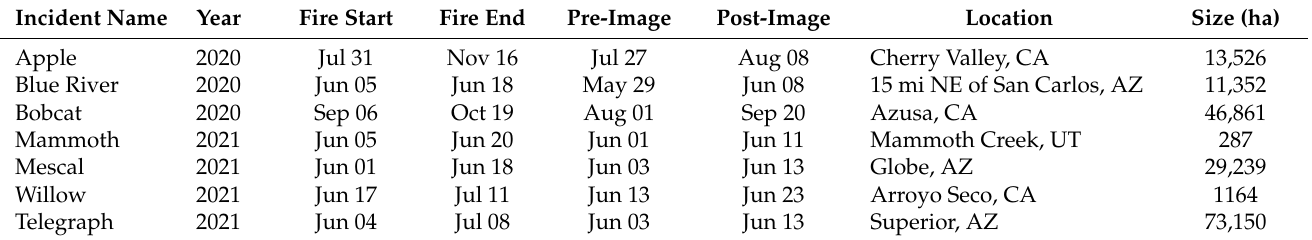
Table 1. Fire incident and imagery details. Scene ID’s can be found in Supplemental Material, Table S3: Scene